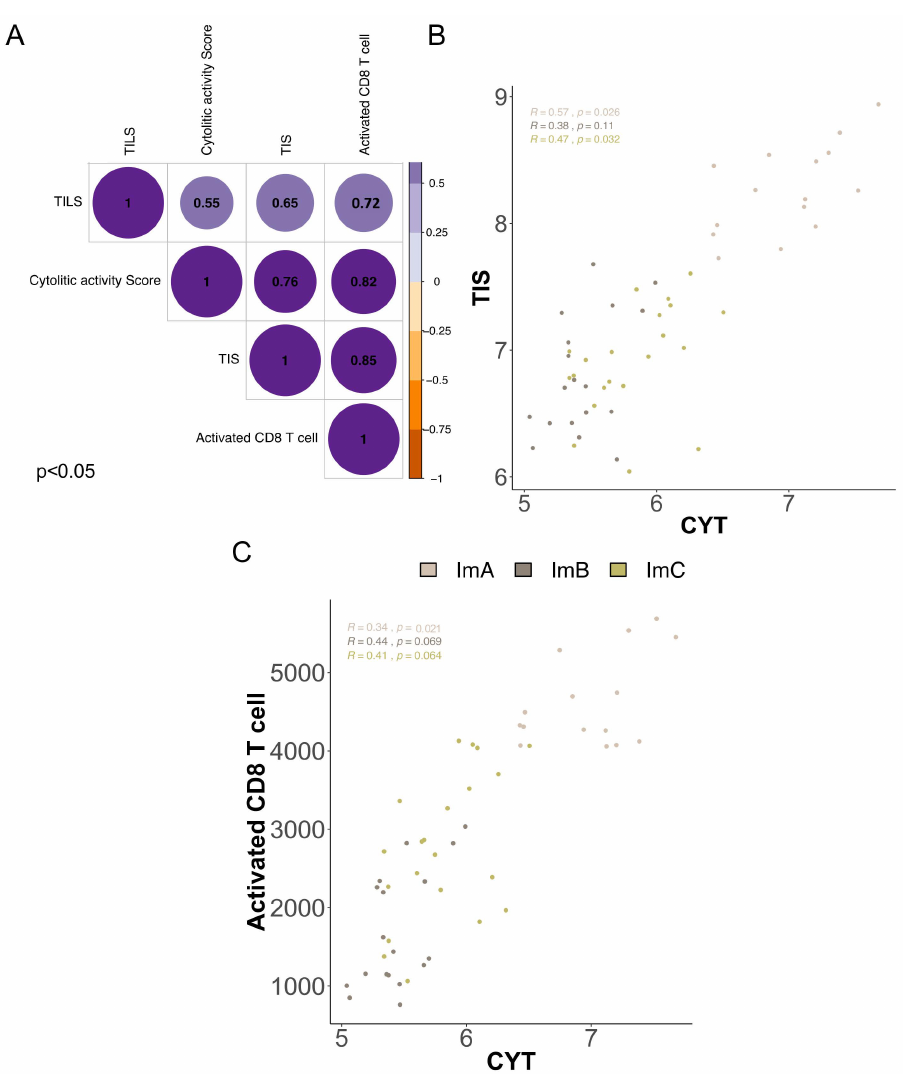
Figure 3. Correlation between local immune features among Im-Clus. ( A ) Matrix correlation of triple negative tumors among local immune features. The bubble color corresponds to the correlation direction. The number presented corresponds to the R value. All correlations presented are significant with p value < 0.05. Scatter plot of ( B ) cytolytic activity (CYT) vs. Tumor Inflammation Signature (TIS) and ( C ) CYT vs. activated CD8 + T cells and their correlation value and statistical significance reported as p value. Each Im-Clus is reported by di ff erent colors as indicated in the legend. All R coe ffi cients are measured by Spearman